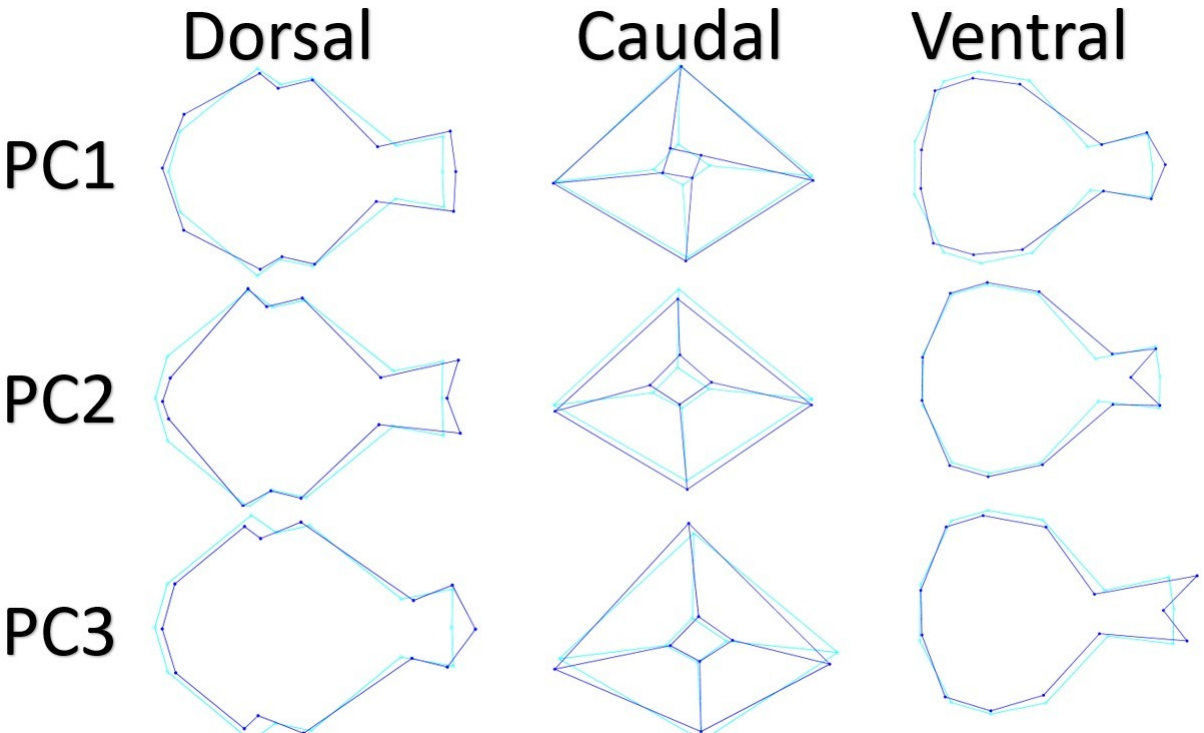
Figure 2. Wire-frame warp plots of changes in skull shape of PC1, PC2. And PC3. The darker blue plots indicate the positive limit of the principal component’s scores.